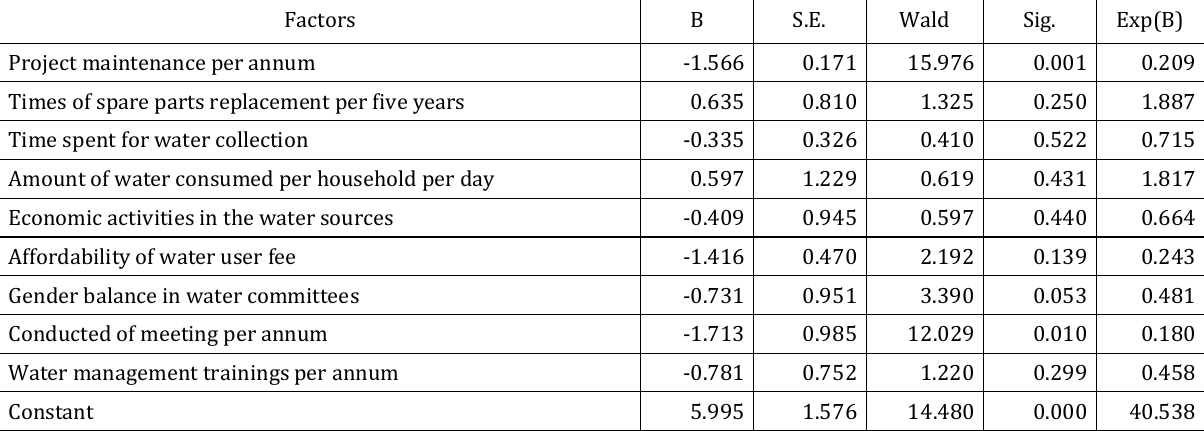
Table 4. Socio-economic and institutional factors affecting the sustainability of water projects